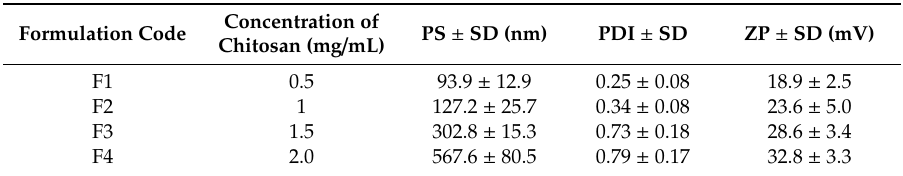
Table 1. E ff ect of increase in chitosan concentration on particle size, polydispersity index, and zeta potential.